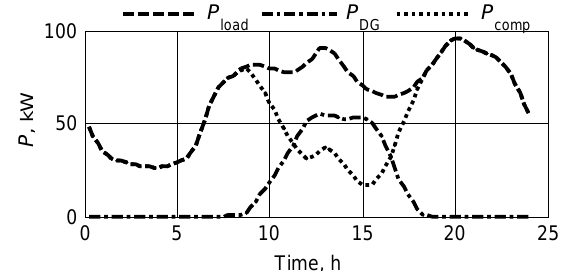
Fig. 10. Prediction curve for P load , P DG and the resulting P comp (scenario 3).